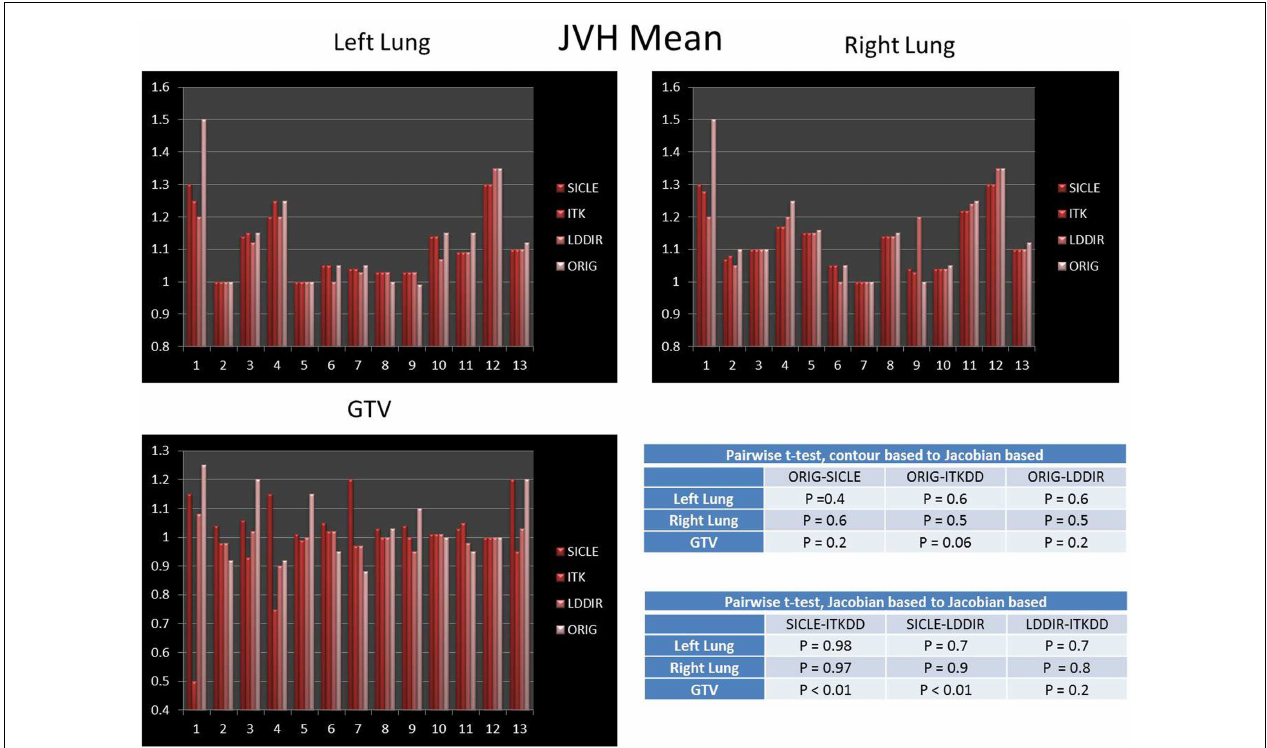
lungs undergo significant change in volume.The agreement between contour based prediction of total volume change and mean JVH prediction is statistically significant for all pairwise comparisons in lungs ( p > 0.4) and not significant in the GTV.